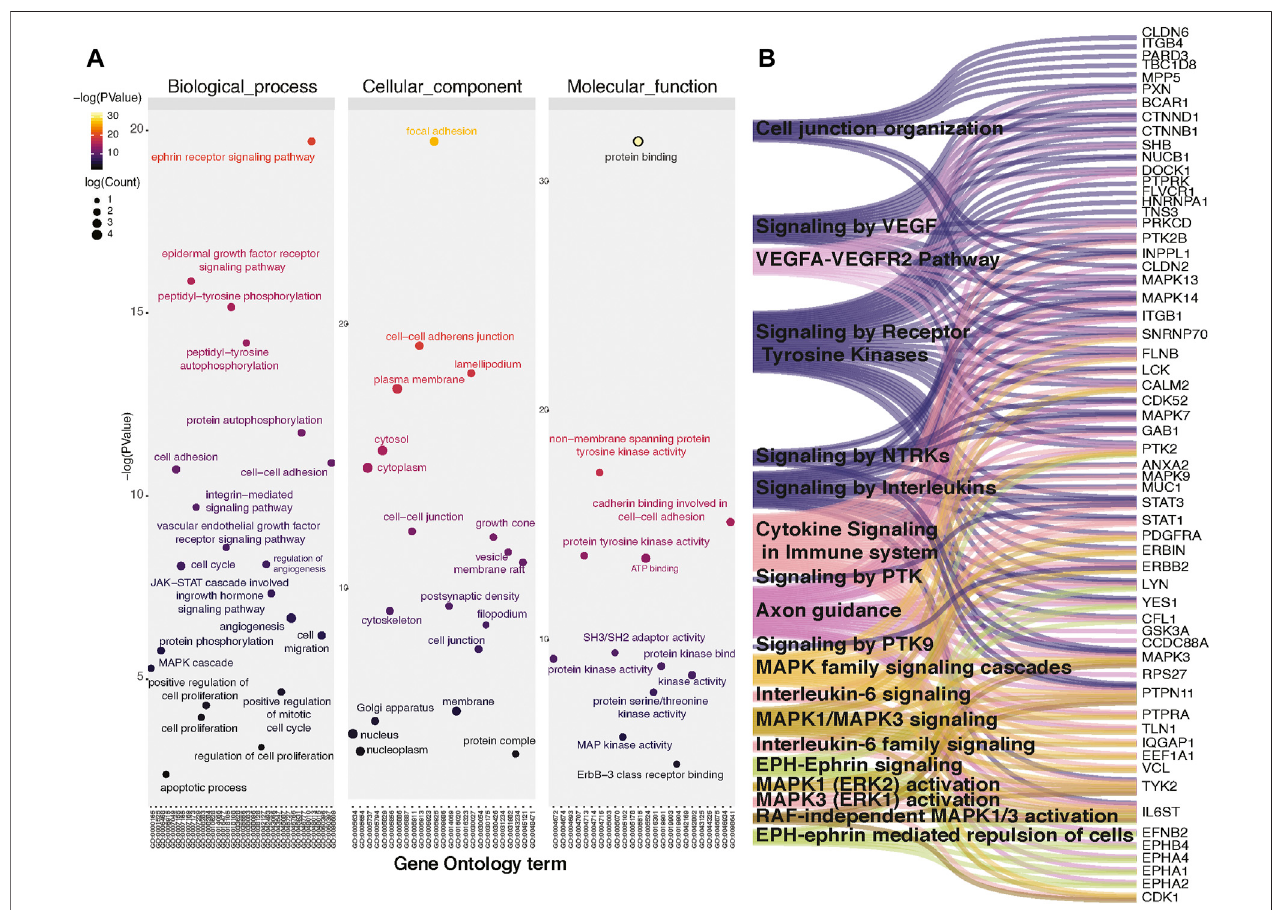
FIGURE 3 | Inhibition of CAMKK2 regulates tyrosine phosphoproteome involved in different cellular processes and pathways. (A) Gene ontology enrichment of biological process, cellular component, and molecular function associated with hypophosphorylated proteins in gastric cancer cells (AGS) upon CAMKK2 inhibition. (B) Pathway analysis associated with hypophosphorylated proteins in AGS cells upon CAMKK2